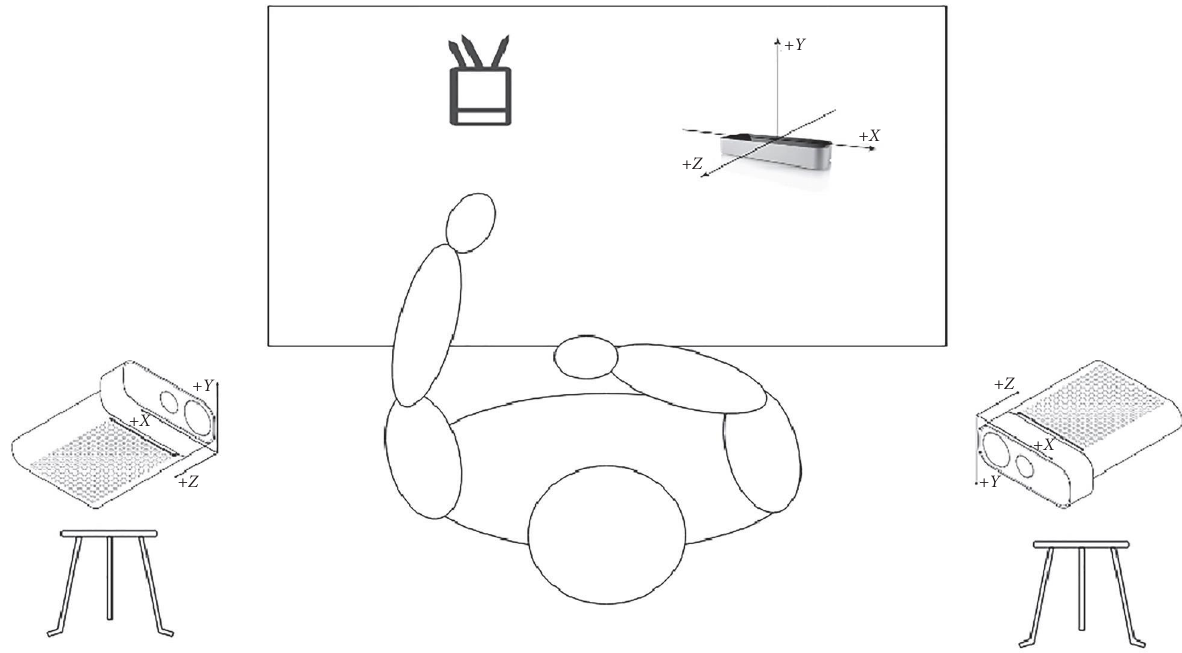
F IGURE 1: Schematic diagram of experimental